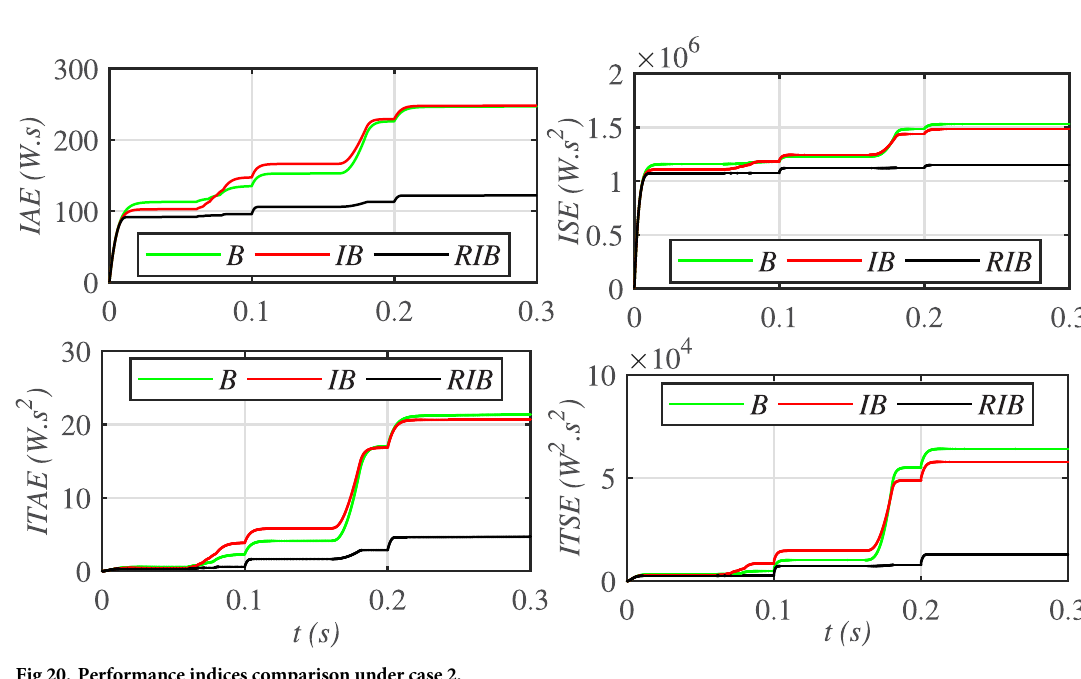
Fig 20. Performance indices comparison under case 2.